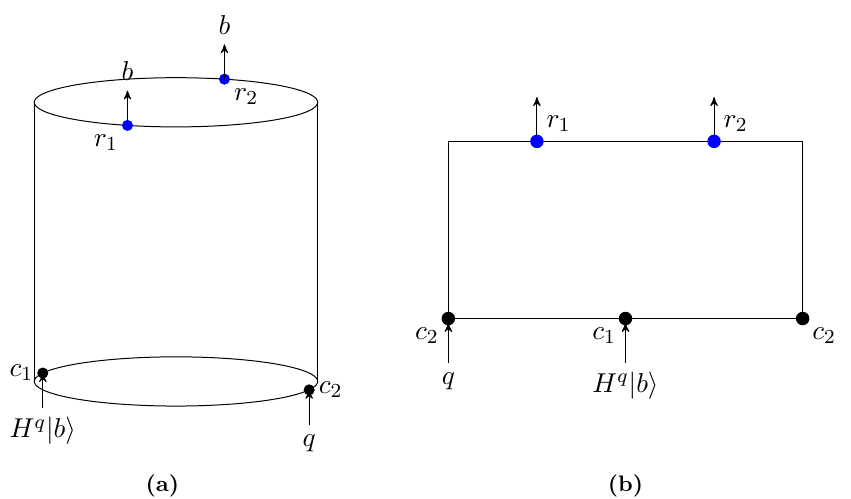
Figure 4. The B 84 task considered in an asymptotically AdS spacetime. The bulk view is shown at left, while the boundary perspective is at right. The task should be possible in the boundary whenever it is possible in the